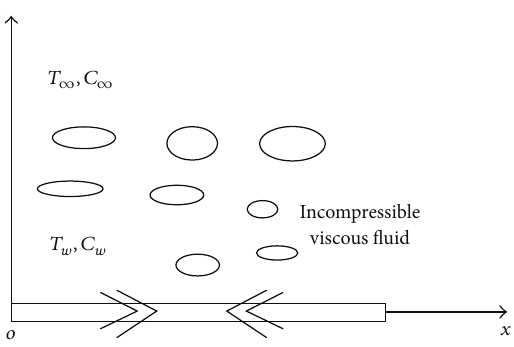
Figure 1: The physical configuration of the problem.